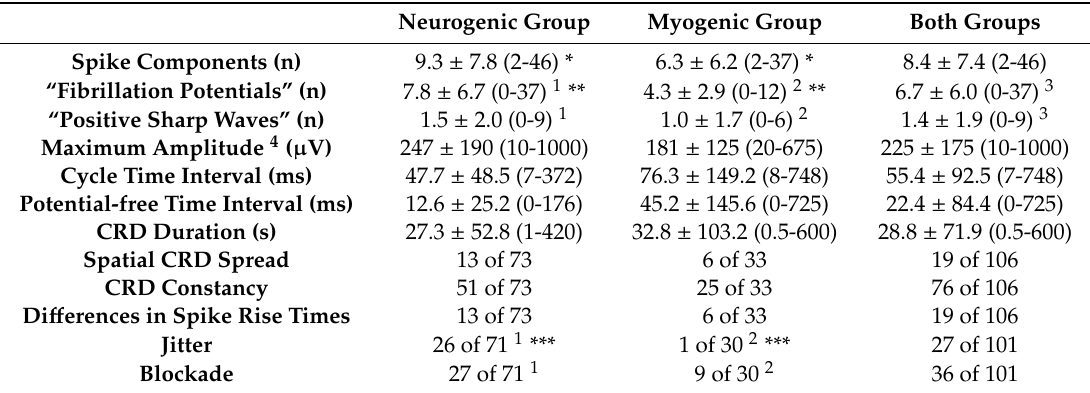
Table 1. Summary of CRD results.